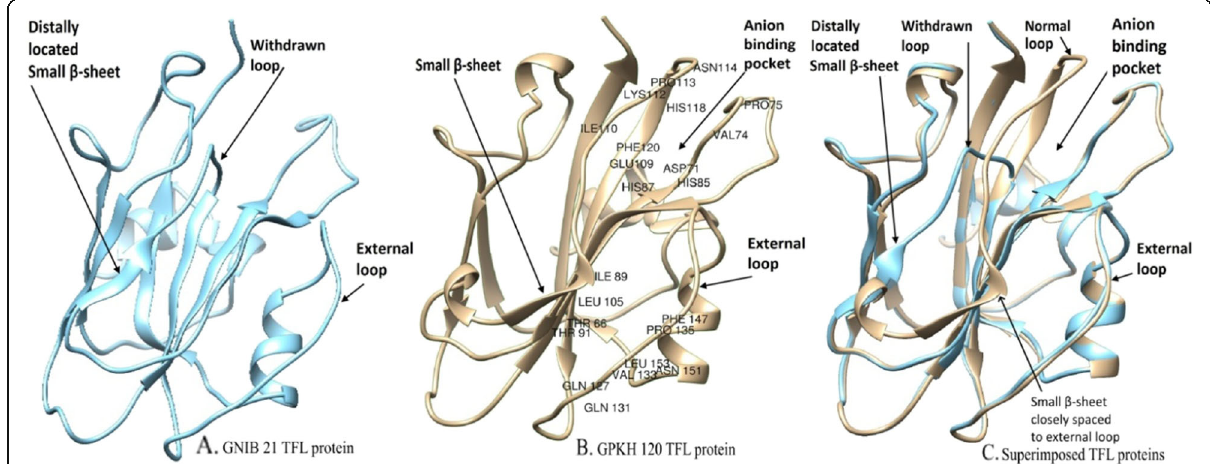
Fig. 4 Comparison of predicted TFL protein structures of two Indian bean genotypes. a The withdrawn loop and distally located small β -sheet away from the external loop are apparent due to deletion of amino acids owing to splice site transition in GNIB 21. b Amino acid residues involved in the formation of binding pockets are depicted for GPKH 120 to narrate structural anomalies between two proteins. The normal loop and well-placed small β -sheet adjacent to the external loop provide wild type flowering suppression activity. c Superimposed wild type and mutant proteins depicts structural abnormalities related to anion-binding pocket and small β